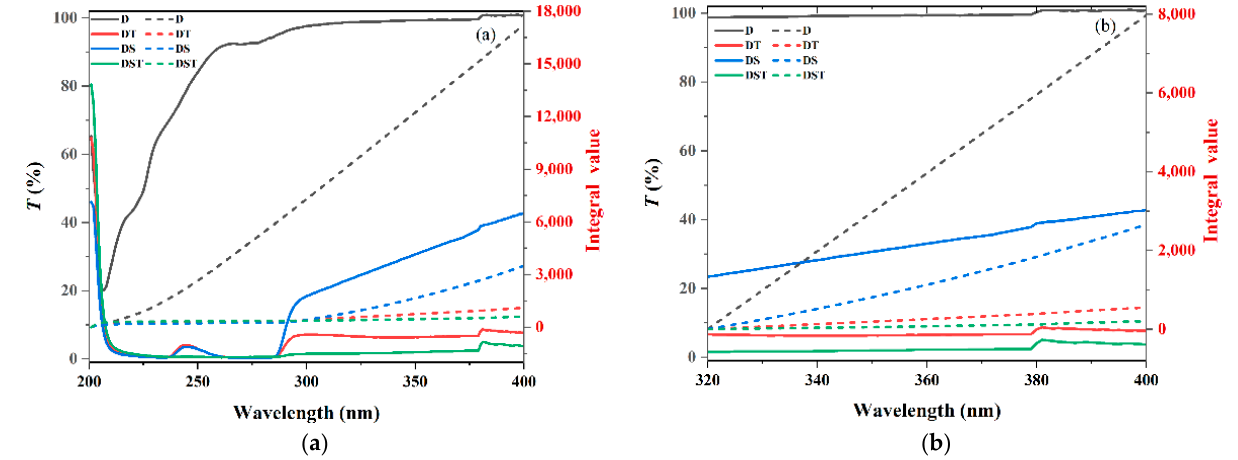
Figure 10. UV–Vis spectra of different groups of solutions in solid lines and integral values of the curves (right Y-axis) represented by dotted lines: ( a ) 200–400 nm; ( b ) 320–400 nm.